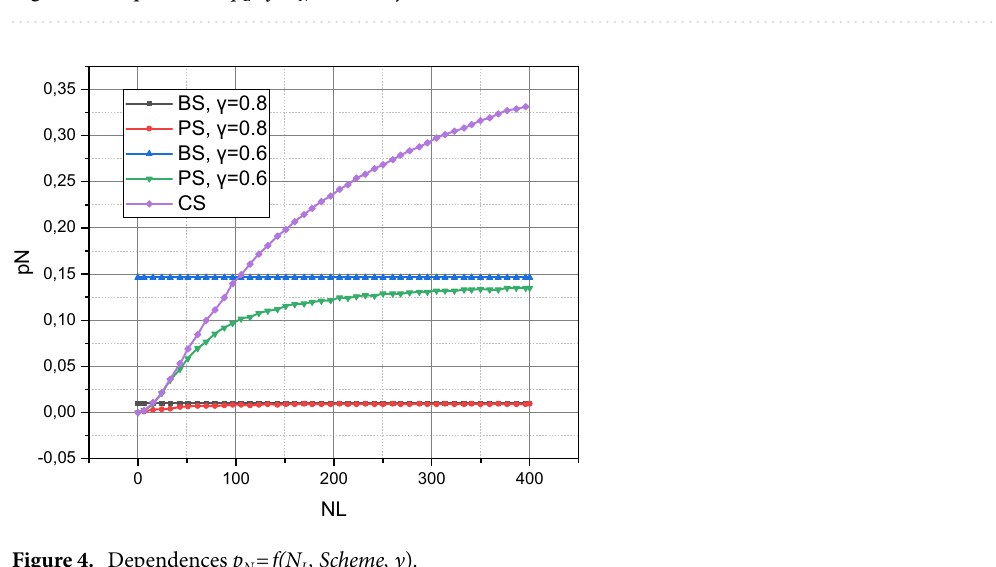
Figure 3. Dependences p L = f(N N , Scheme, γ ).